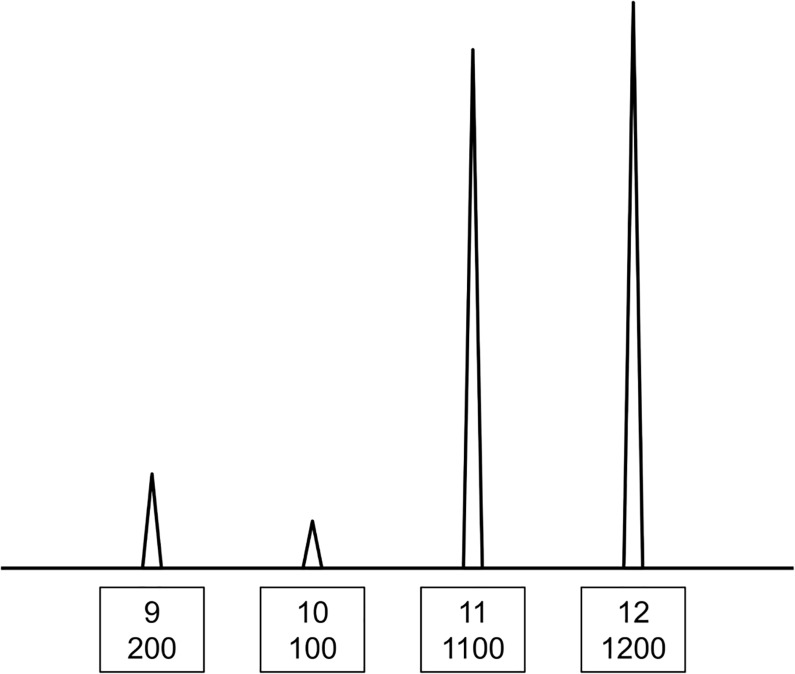
Example of the crime stain profile (CSP) in a single locus.